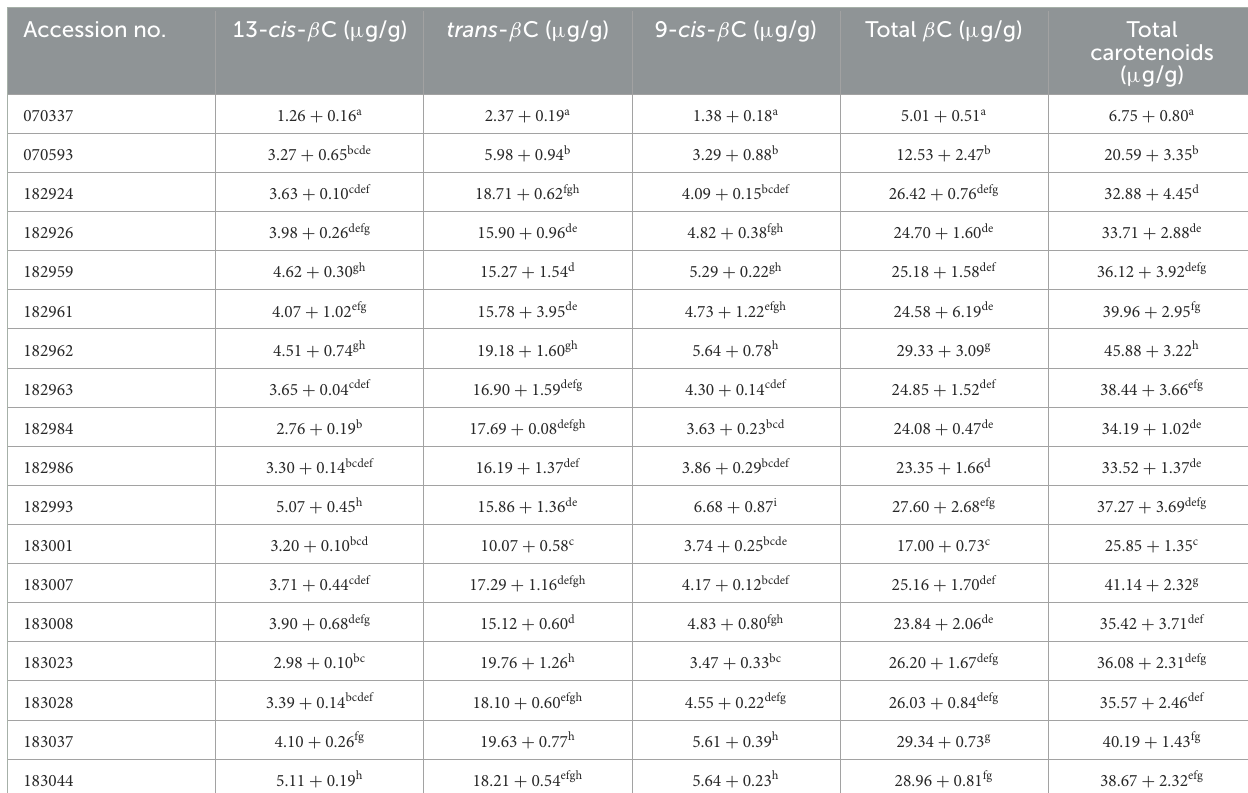
TABLE 1 Carotenoids profile of 18 elite yellow-fleshed cassava genotypes (on a dry weight basis). Accession